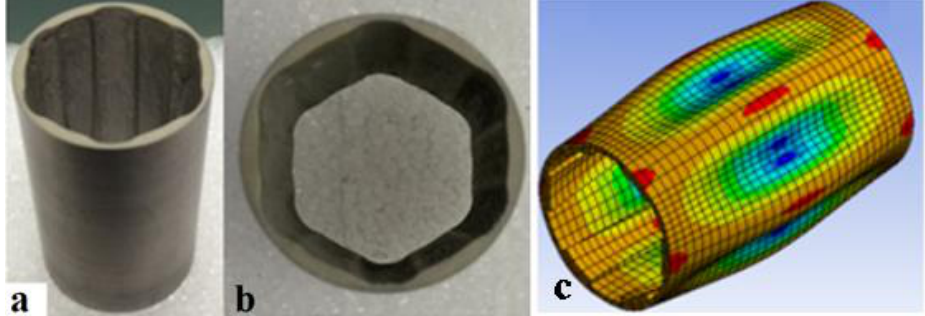
Figure 5. Circumferentially stepped-thickness piezoelectric transducer in two views ( a , b ); vibration mode shape with circumferential and axial mode numbers of 6 and 1, respectively ( c ) [2].